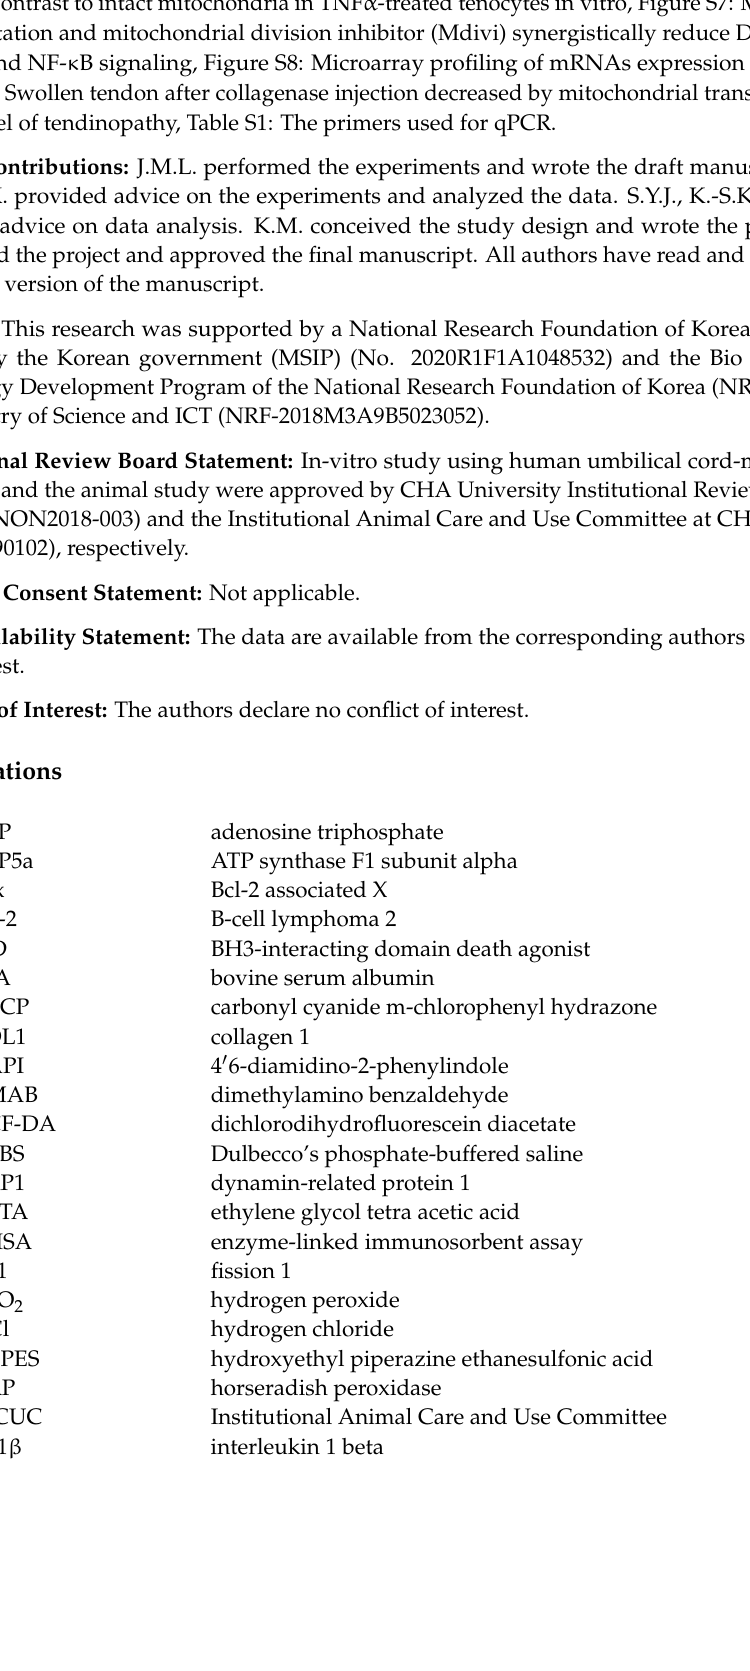
image of western blot analysis, Figure S4: Characterization of isolated mitochondria from human umbilical cord mesenchymal stem cells (UC-MSCs), Figure S5: Full fluorescence microscopy of tenocytes after mitochondria transfer, Figure S6: Ruptured mitochondria do not show beneficial effects in contrast to intact mitochondria in TNF α -treated tenocytes in vitro, Figure S7: Mitochondrial transplantation and mitochondrial division inhibitor (Mdivi) synergistically reduce Drp1, a fission marker, and NF- κ B signaling, Figure S8: Microarray profiling of mRNAs expression on tenocytes, Figure S9: Swollen tendon after collagenase injection decreased by mitochondrial transplantation in a rat model of tendinopathy, Table S1: The primers used for